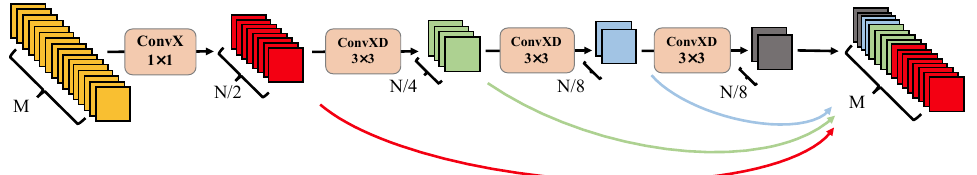
Figure 4. Structure diagram of flexible dilated convolution. ConvXD denotes ConvX with dilated convolution.